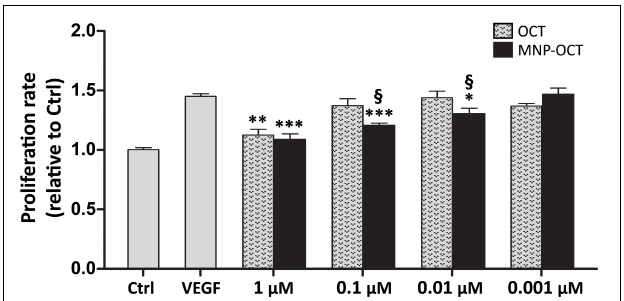
FIGURE 3 | Dose-response of the effects of OCT and of MNP-OCT on HREC proliferation. Data are plotted as mean ± SEM. ∗ p < 0.05, ∗∗ p < 0.01, and ∗∗∗ p < 0.001 vs. VEGF; § p < 0.05 vs. OCT; n = 4.